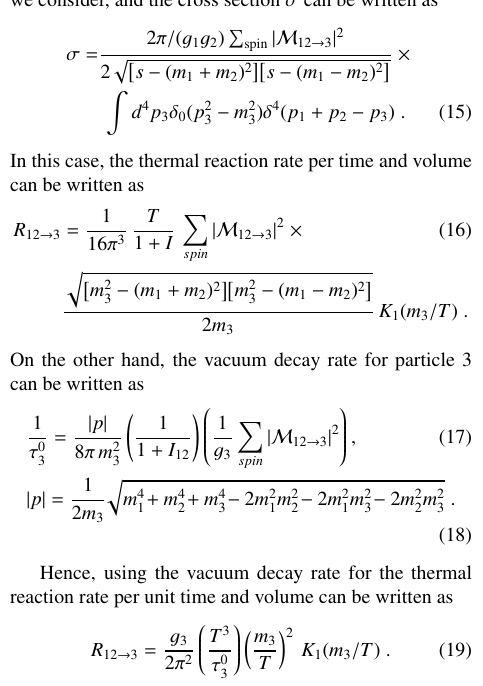
( T f ) = 1 / H ( T f ), → K ± K ± becomes →